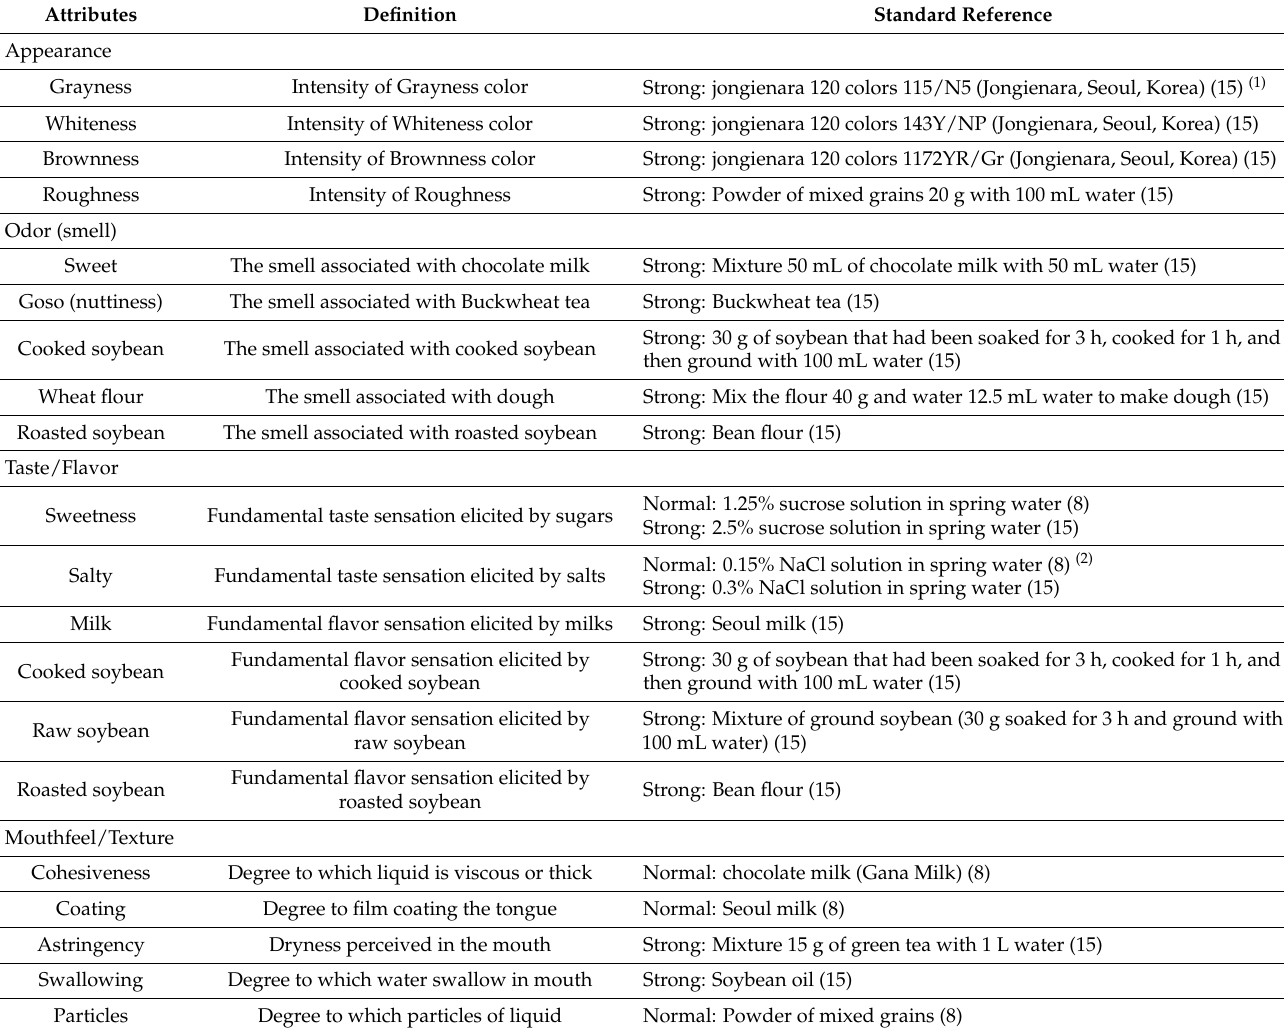
Table 2. Definition and standard reference of descriptive attributes of